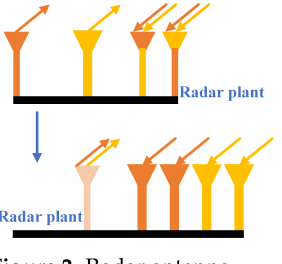
Figure 2. Radar antenna.